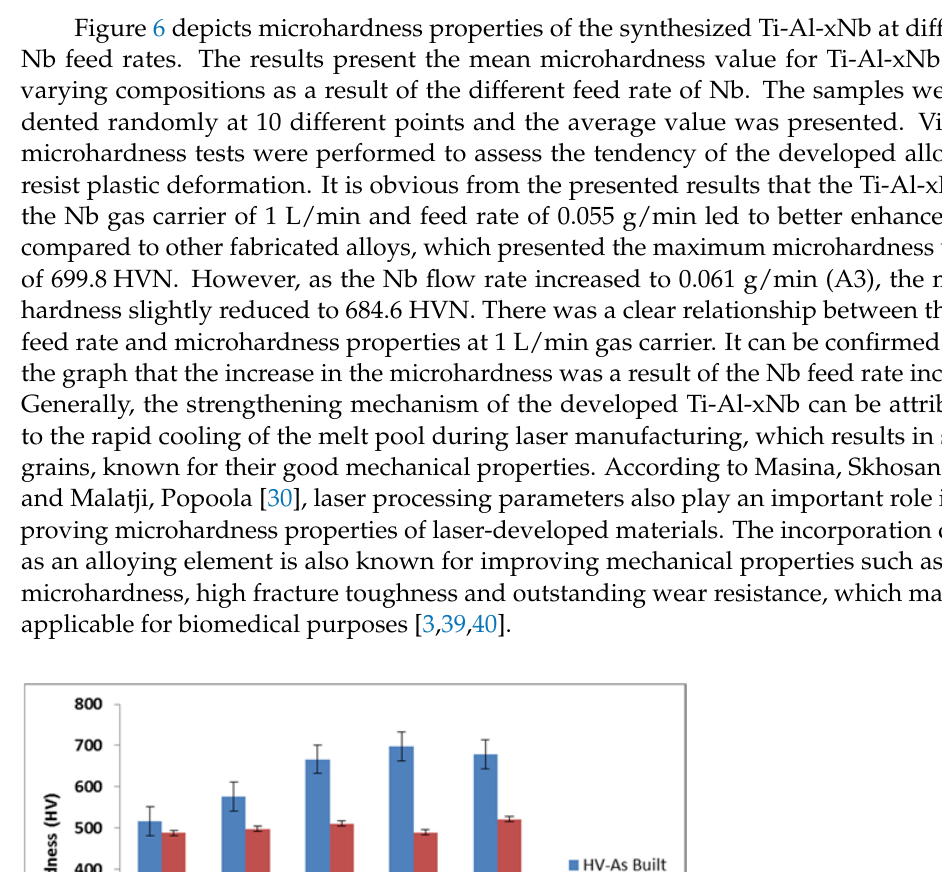
Figure 5. Densification results of synthesized Ti-Al-xNb.